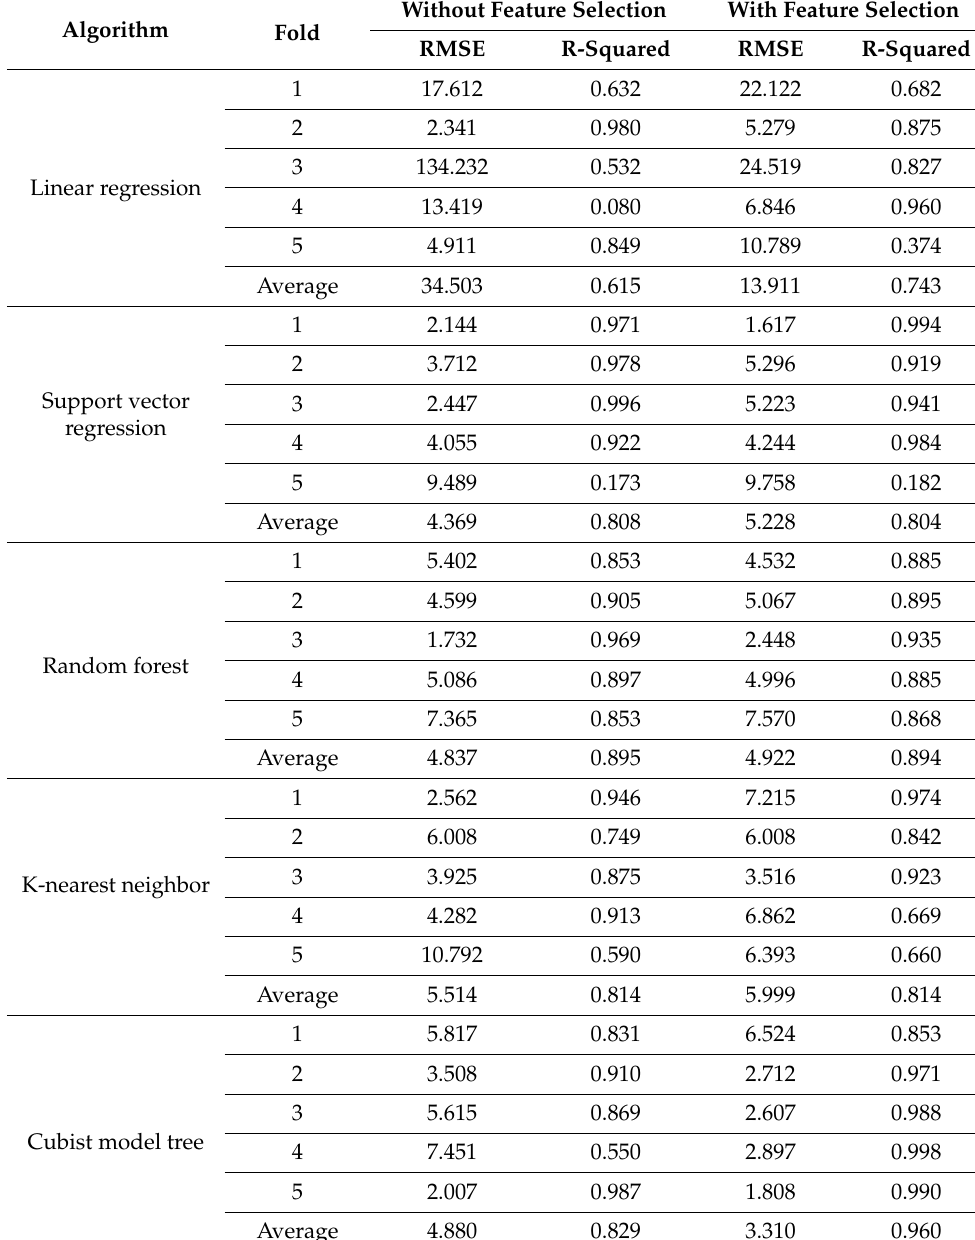
Table 3. Performance results of the machine learning